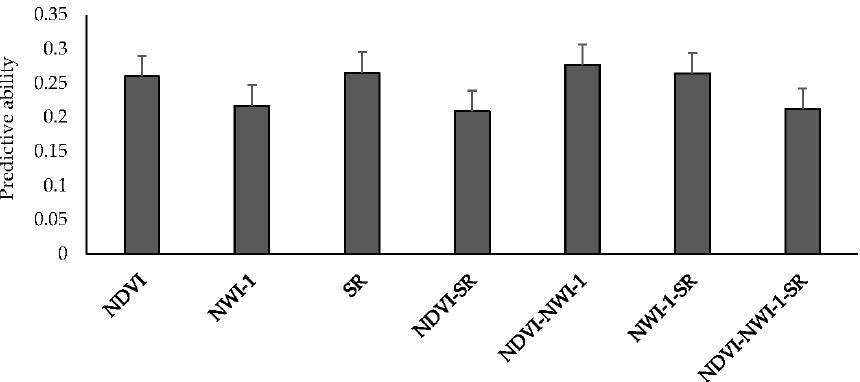
Figure 2. Mean predictive ability for grain yield across different environments using spectral indices collected from high-throughput field phenotyping under an IBCF (item-based collaborative filtering) recommender system. NDVI — Normalized Difference Vegetative Index; NWI-1 — Normalized Water Index-1; SR — Simple Ratio. Bars indicate standard errors.